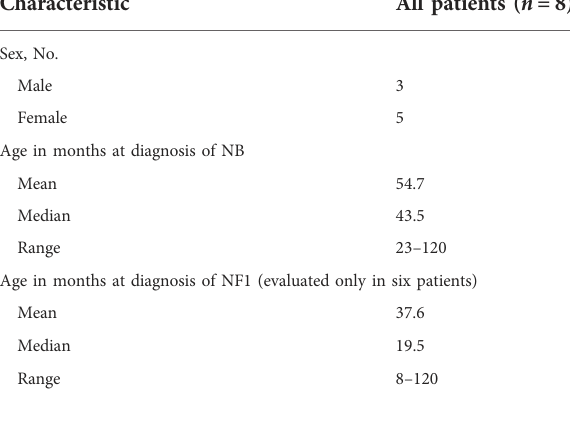
TABLE 3 Demographic information of the study patients.